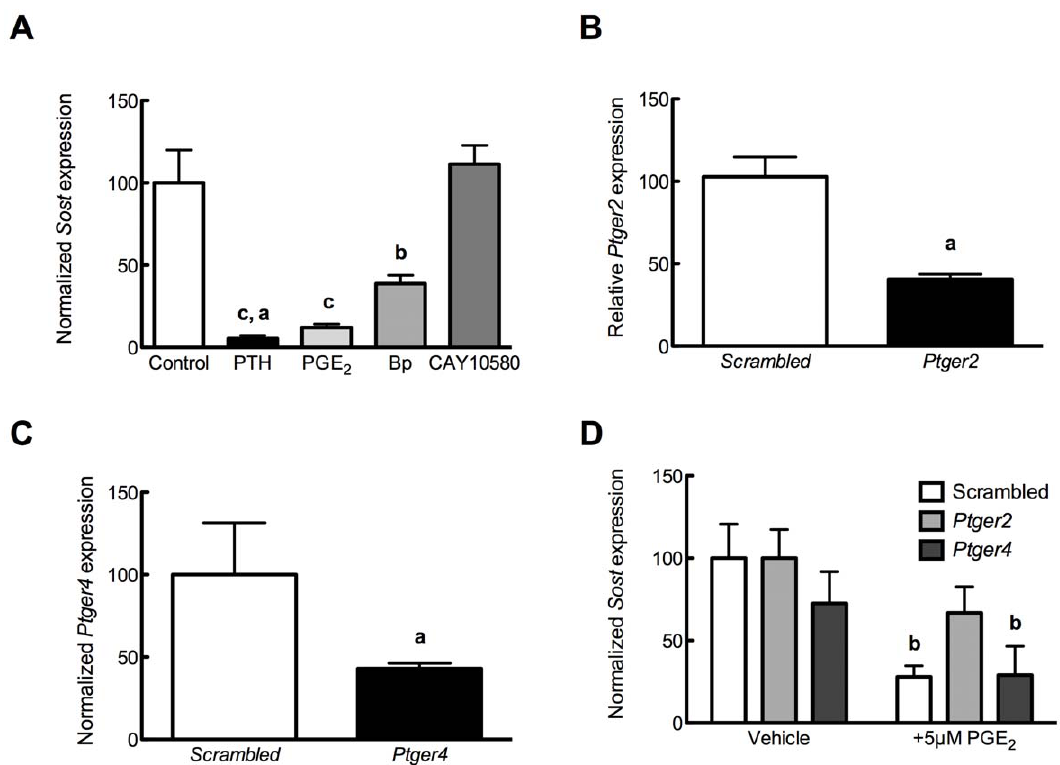
Figure 4. PGE 2 signals through Ptger2 to decrease Sost expression. ( A ) Cells were cultured for 3 hours in the presence of PTH (100 nM), PGE 2 , EP2 agonist butaprost, or EP4 agonist CAY10580 (each 500 nM). Sost expression was analyzed by qPCR and normalized to Rpl32 . n=5 samples. Compared to vehicle control, b indicates p , 0.01 and c indicates p , 0.001; a indicates p , 0.01 versus CAY10580. ( B ) UMR106.01 cells were cultured with 50 nM of scrambled or Ptger2 siRNA for 48 hours, after which Ptger2 expression was examined by qPCR. n=4 samples. Compared to vehicle control, a indicates p , 0.05. ( C ) UMR106.01 cells were cultured with 50 nM of scrambled or Ptger4 siRNA for 48 hours, after which Ptger4 expression was examined by qPCR. n=4 samples. Compared to vehicle control, a indicates p , 0.05. ( D ) UMR106.01 cells were cultured with 50 nM of scrambled, Ptger2 , or Ptger4 siRNA for 48 hours, then with 5 m M PGE 2 for 3 hours, after which time total RNA was collected and analyzed for Sost and Rpl32 . n=5 samples. Compared to vehicle control, b indicates p ,